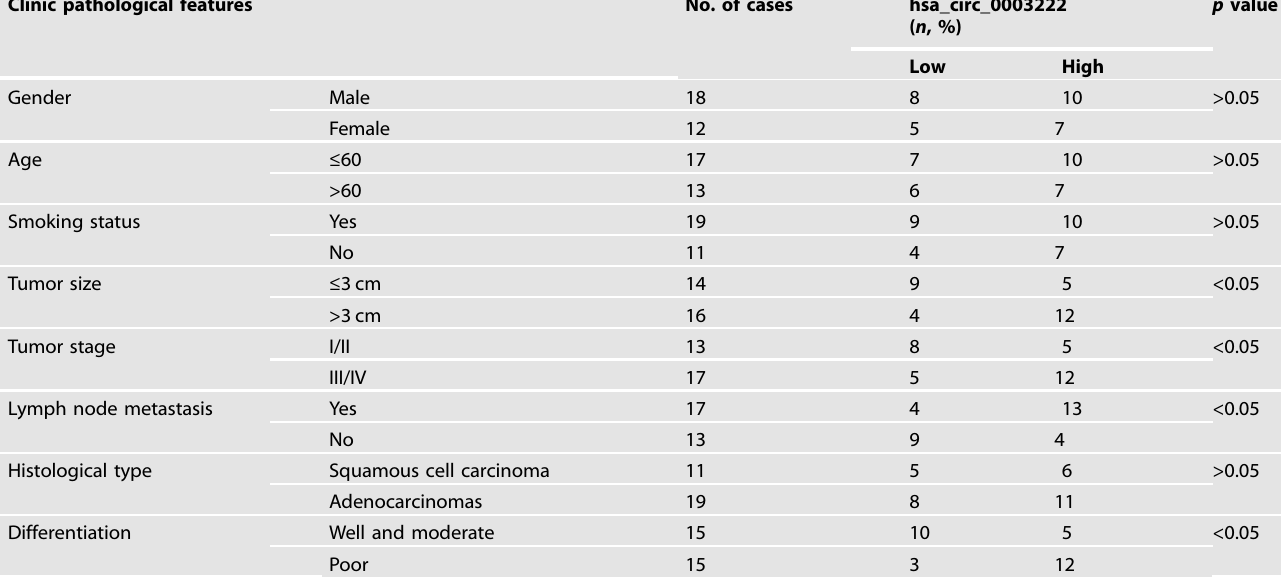
Table 1. Relationship between hsa_circ_0003222 expression and the clinical-pathological characteristics in of NSCLC patients ( n = 30). Clinic pathological features No. of